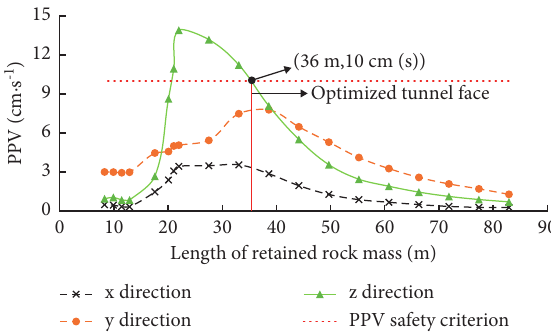
Figure 10: Relationship between PPV and the length of the retained rock mass at the tunnel entrance.